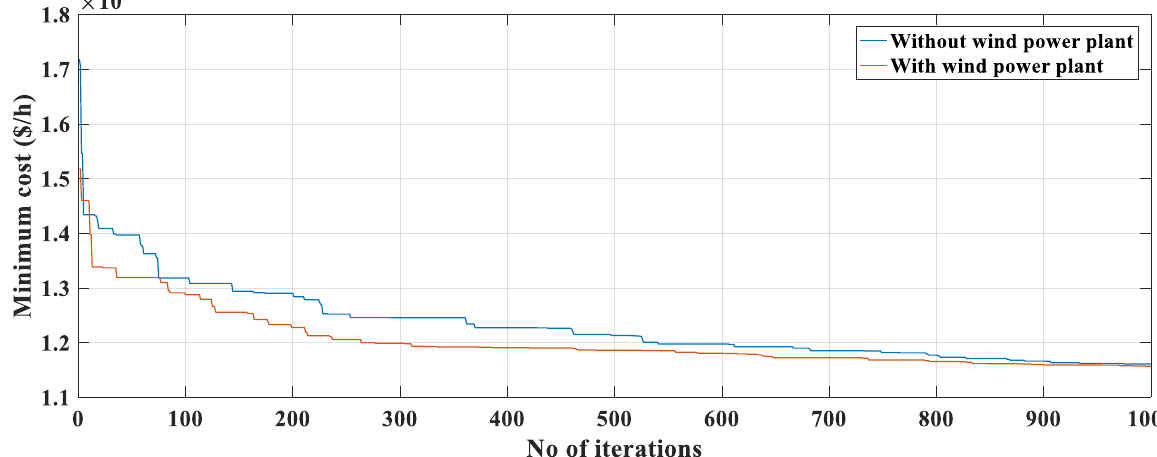
Figure 4. Minimum cost curve considering VPL effect. Table 1. Optimal distribution of power–heat production considering VPL effect.